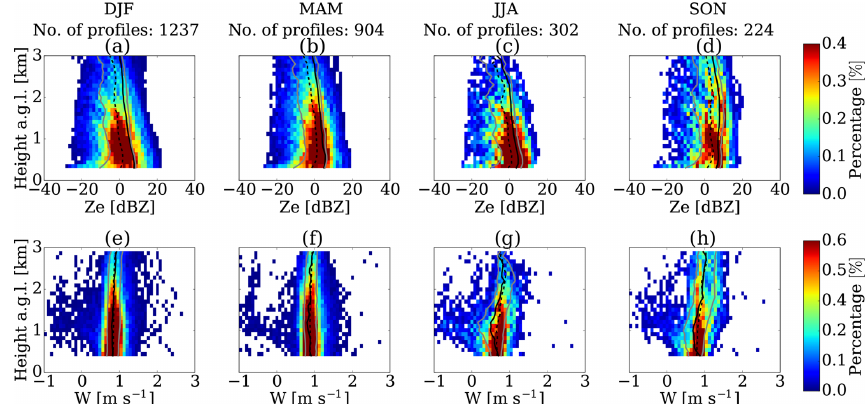
Figure 8. Same as Fig. 7, but for the Princess Elisabeth